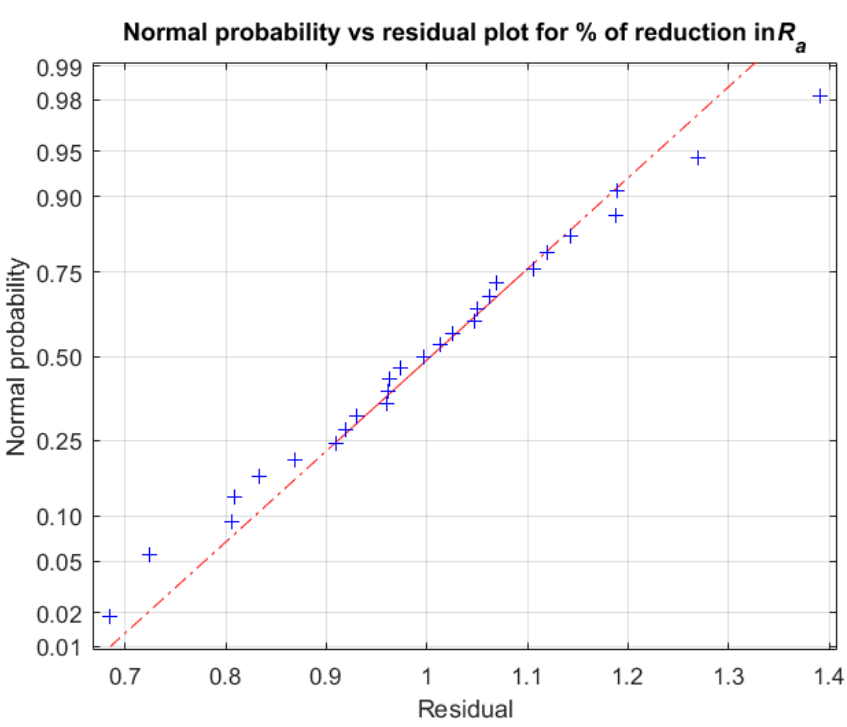
Figure 10. Normal probability vs. residual plot for Al 2 O 3